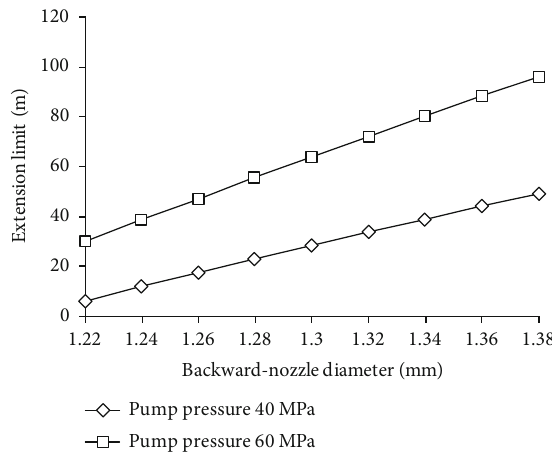
Figure 7: Extension limit in fl uenced by the di ff usion angle.